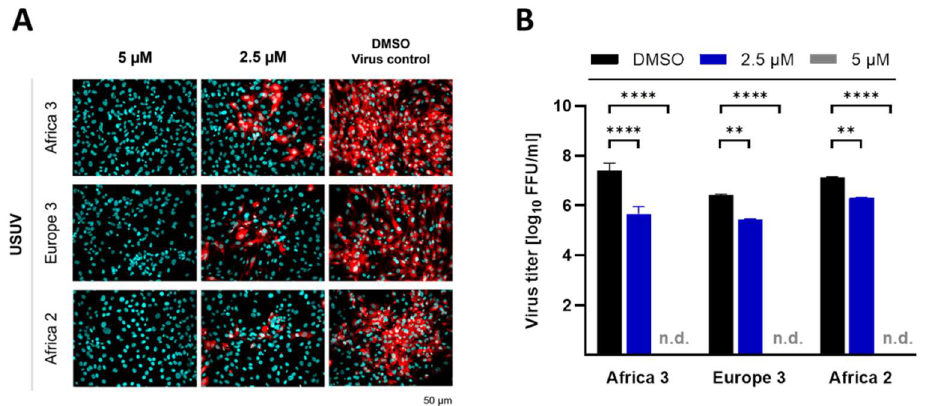
Figure 4. Antiviral activity of ivermectin against several USUV strains in vitro. TME-R cells were infected with USUV lineages Africa 3, Europe 3 and Africa 2 at MOI of 0.1 in the presence of selected ivermectin concentrations. Readout was performed after 72 h post infection. ( A ) Immunofluorescence staining of USUV-infected cells was performed in the presence of selected ivermectin concentrations. Flavivirus antigen is depicted in red and cell nuclei stained with DAPI are shown in cyan blue. ( B ) Virus titer was determined from supernatants of infected cells treated with 2.5 µ M and 5 µ M of ivermectin compared to vehicle control (DMSO). N.d. = not detectable. Data represent mean values ± SD from three independent experiments. Statistical analysis was performed by ANOVA and Dunnett’s post-hoc multiple comparisons test indicating statistical significance as n.d. (not detectable, under detection limit), ** ( p < 0.01) and **** ( p <